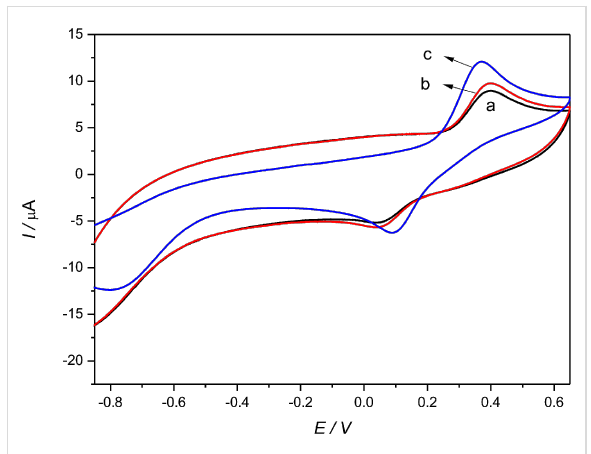
Figure 5: Cyclic voltammograms of of laccase – Nafion/GCE (a), laccase/GCE (b), laccase – Nafion–ECNFs/GCE (c) toward 300 µM catechol in 0.2 M acetate buffer (pH 4.0).